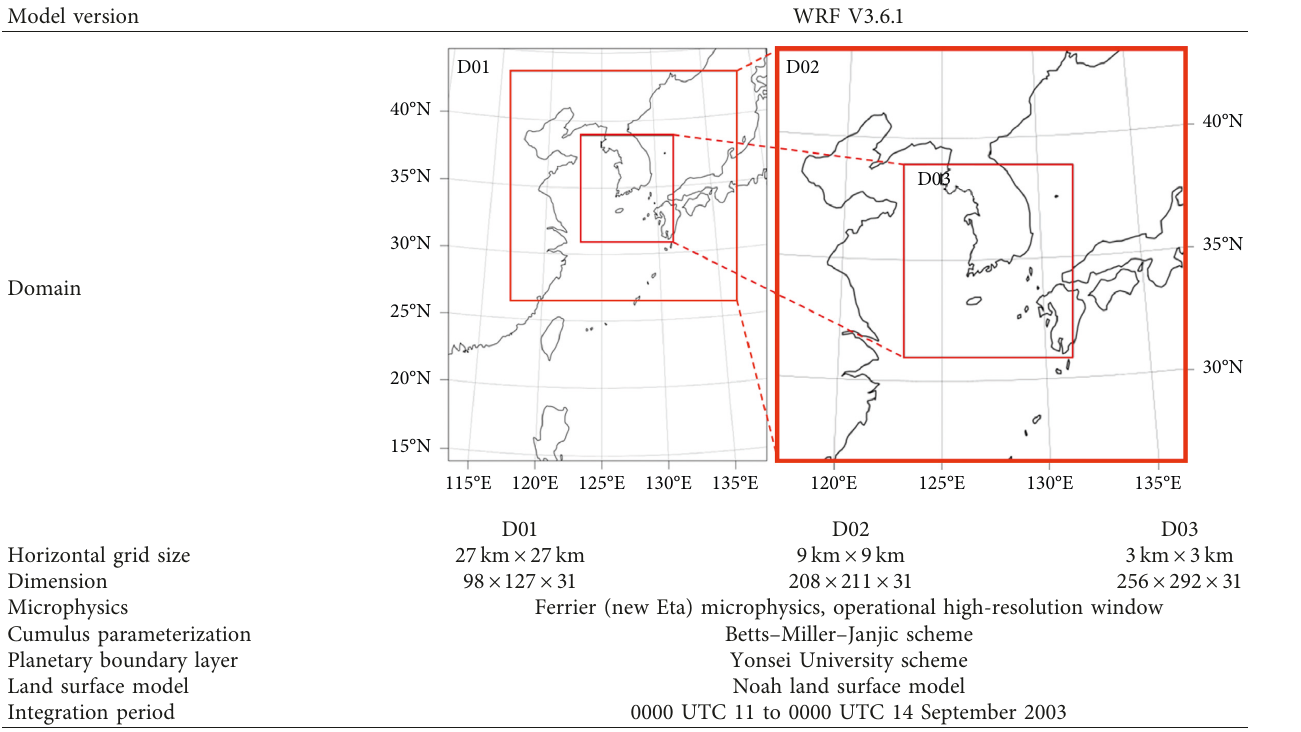
Table 1: Summary of the WRF model configuration